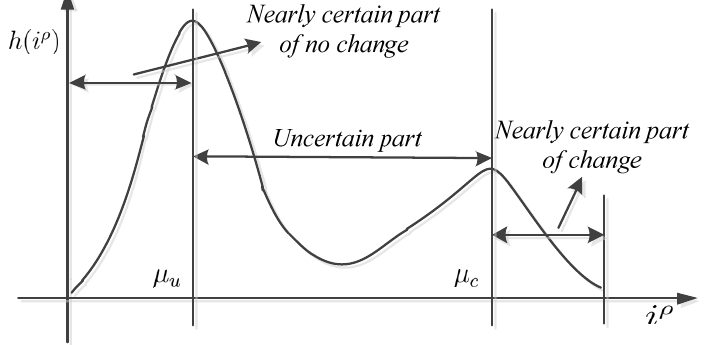
ρ and definitions of uncertain and nearly